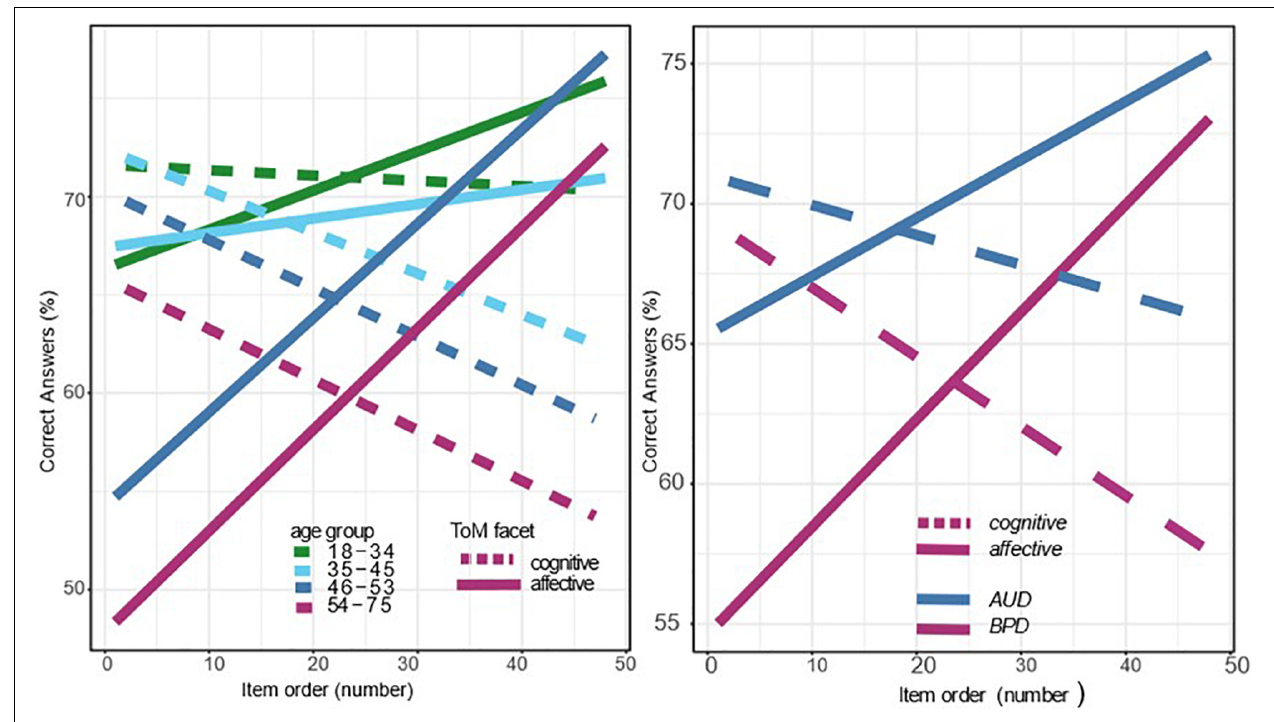
FIGURE 2 | Course of affective and cognitive ToM performance over the test duration.